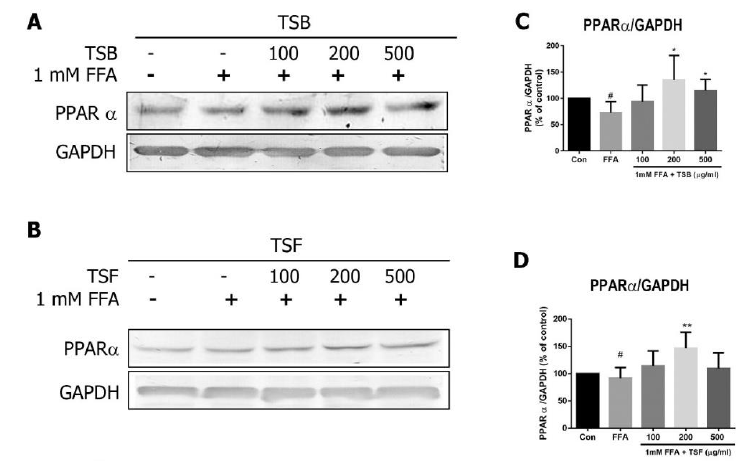
Figure 8. TSB and TSF ’s effects on PPAR α expression in FFA-treated HepG2 cells. ( A and B ) Immunoblots of PPAR. ( C and D ) The bar graphs show densitometric data (mean ± SD) from three to five independent experiments. # P < 0.05 compared with the control group (con). * P < 0.05 and ** P < 0.01 compared with the FFA group.